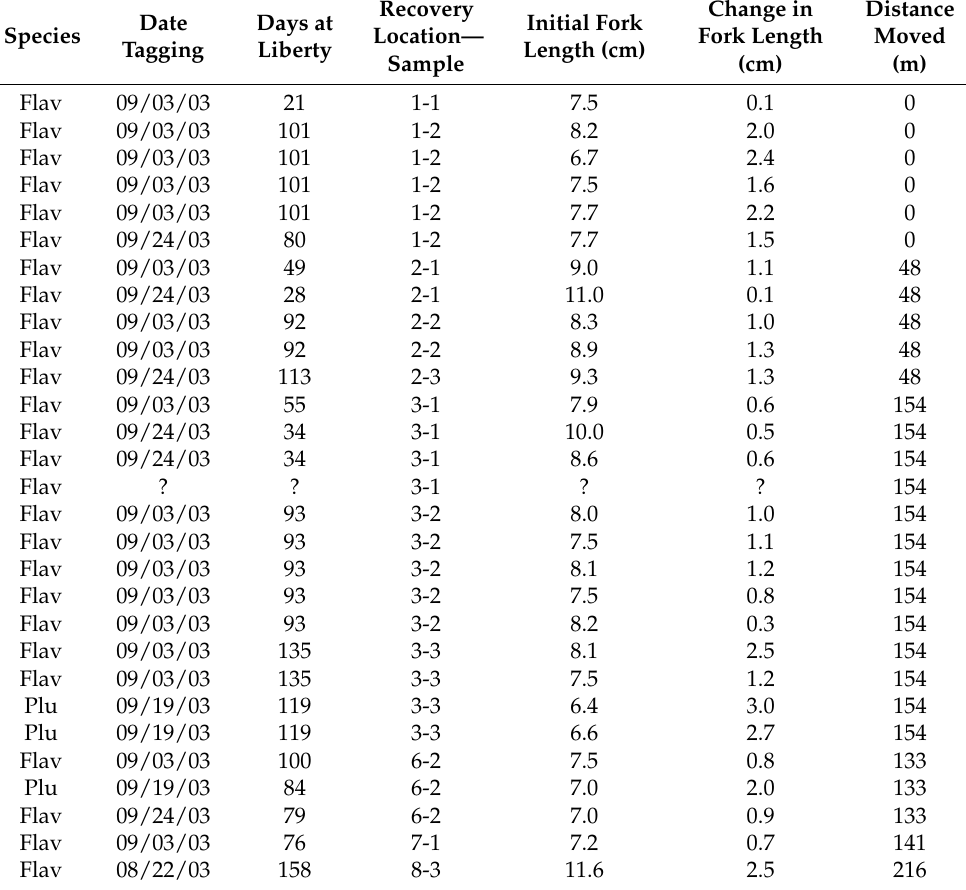
Table 4. Recovery data for ontogenetic movement of small, tagged juveniles of Haemulon flavolineatum (Flav) and H. plumierii (Plu) among school groups. The numbers before the dash in the recovery column is the school group (location) and the number after the dash is the visit (time).